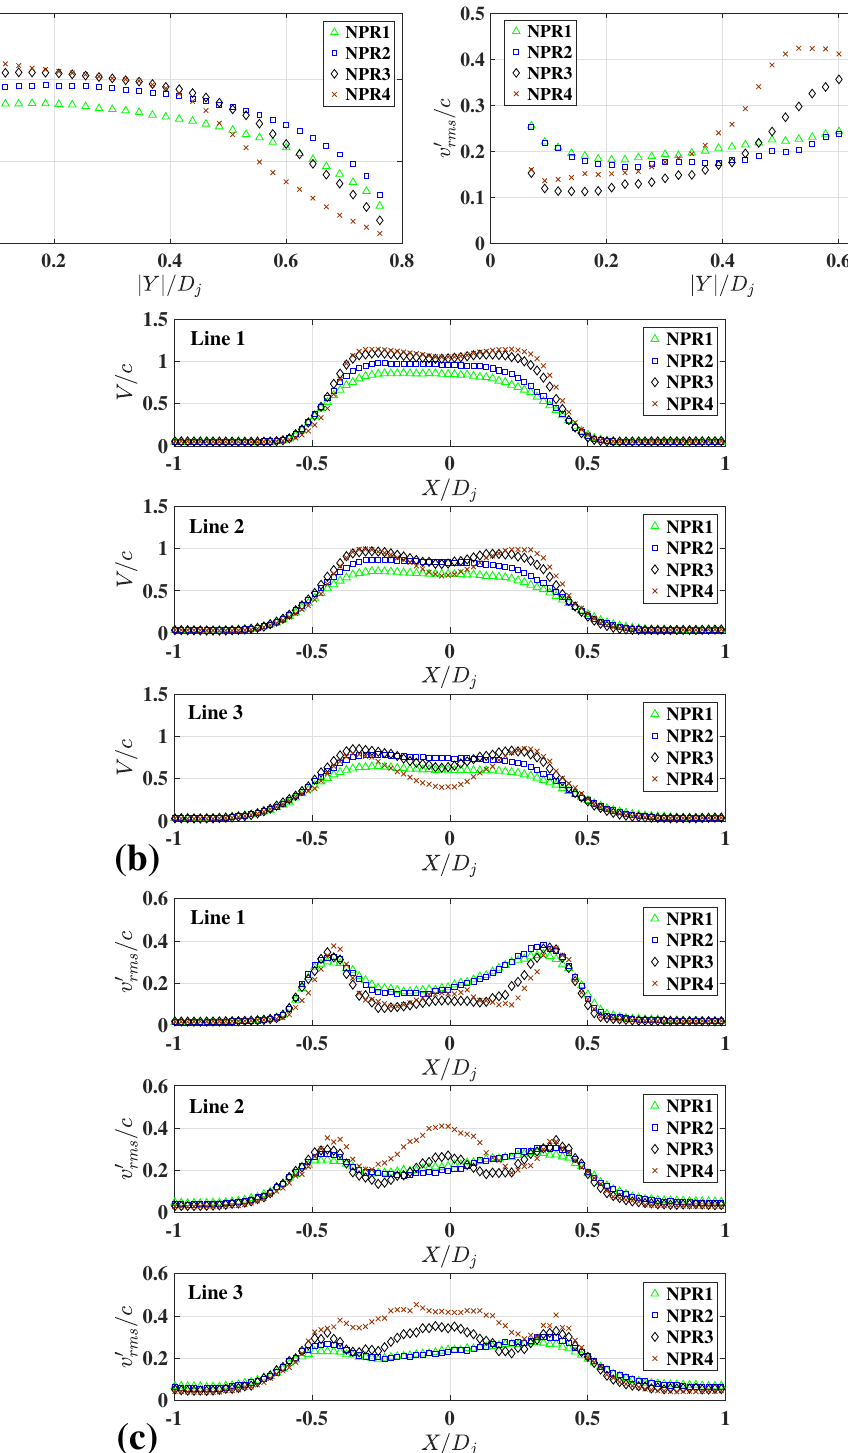
Figure 9. Comparisons of statistical results obtained from PIV measurements of under-expanded impinging jets with e = 10 mm ( e / D j = 0.82) for various values of NPRs, i.e., NPR 1 = 2, NPR 2 = 2.2, NPR 3 = 2.5, and NPR 4 = 2.77. ( a ) Normalized mean axial velocity, V / c and normalized RMS fluctuating axial velocity v (cid:48) rms / c along the jet centerline ( x = 0); ( b , c ) showed normalized statistical profiles of V / c and v (cid:48) rms / c , respectively, obtained along Line 1 ( y = − 2.54) mm, Line 2 ( y = − 3.35) mm, and Line 3 y = − 7.46